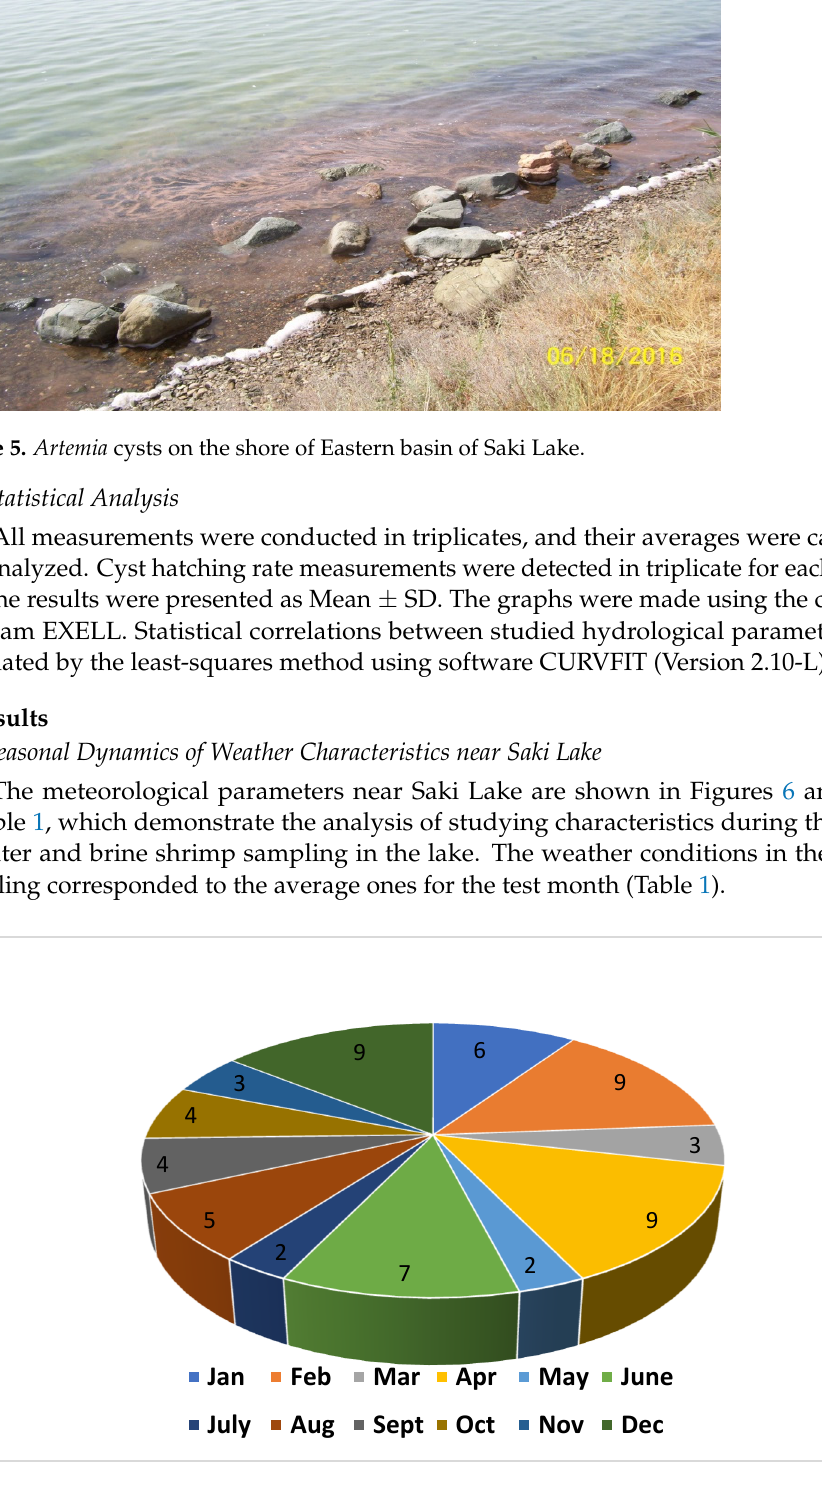
Figure 7. The level of precipitation at the studying area in 2022. Table 1. Characteristics of the meteorological parameters in the sampling period near Saki Lake in 2022. Date